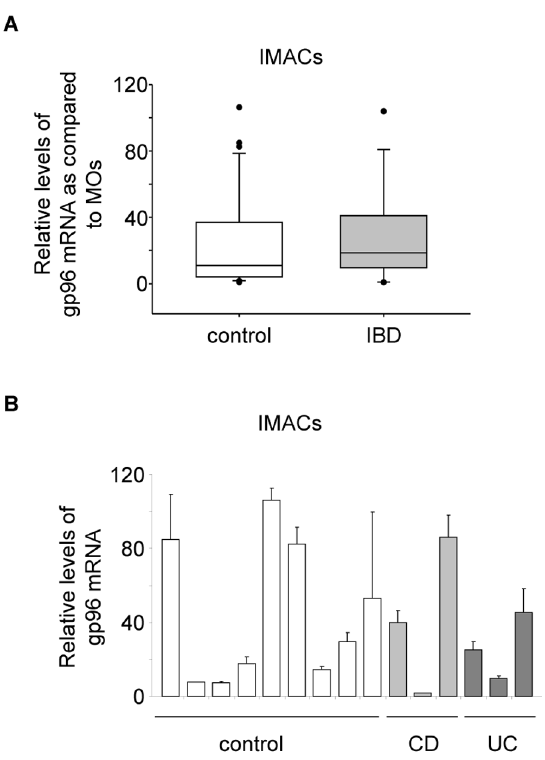
Figure 1. mRNA expression of gp96 in IMACs from IBD and control patients. Control patients comprised 31 with cancer, 3 with fistulae, 1 with volvulus, and 1 healthy patient, 8 with diverticulitis, and 3 with diverticulosis. IBD patients comprised 6 CD and 5 UC patients. (A) Average expression (vs. GAPDH) from IMACs of control (n=47) and IBD patients (n=11). Error bars represent the standard deviation of the mean of all analysed patients. (B) Selected expression levels of IMACs from single patients. The expression in MOs was used as a reference and set to 1. Error bars represent the standard deviation of a single experiment measured in triplicate.